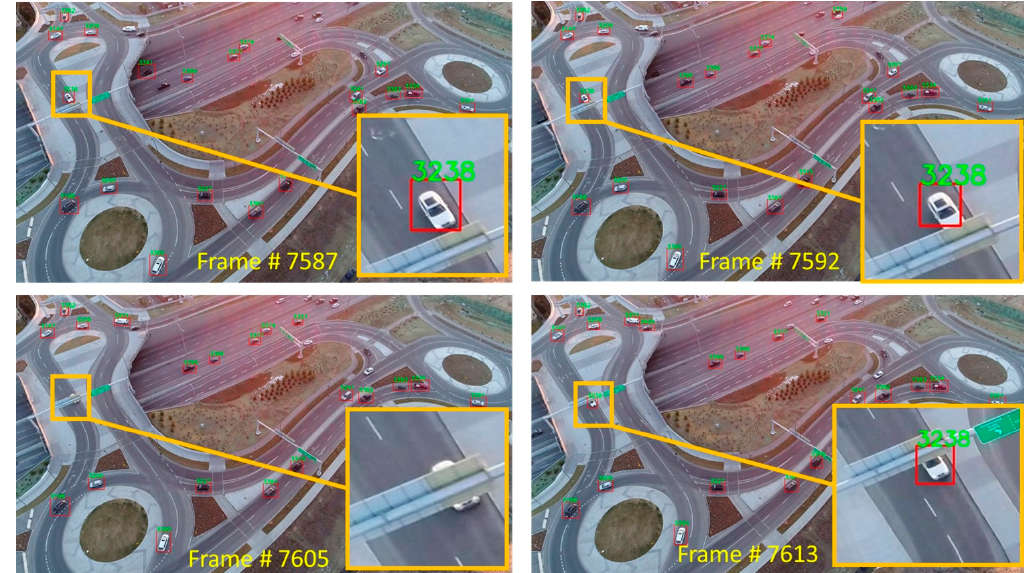
Figure 10. The identity of vehicles is correctly recovered even though they are occluded by other objects for several frames. These examples are selected from DJI video 1.